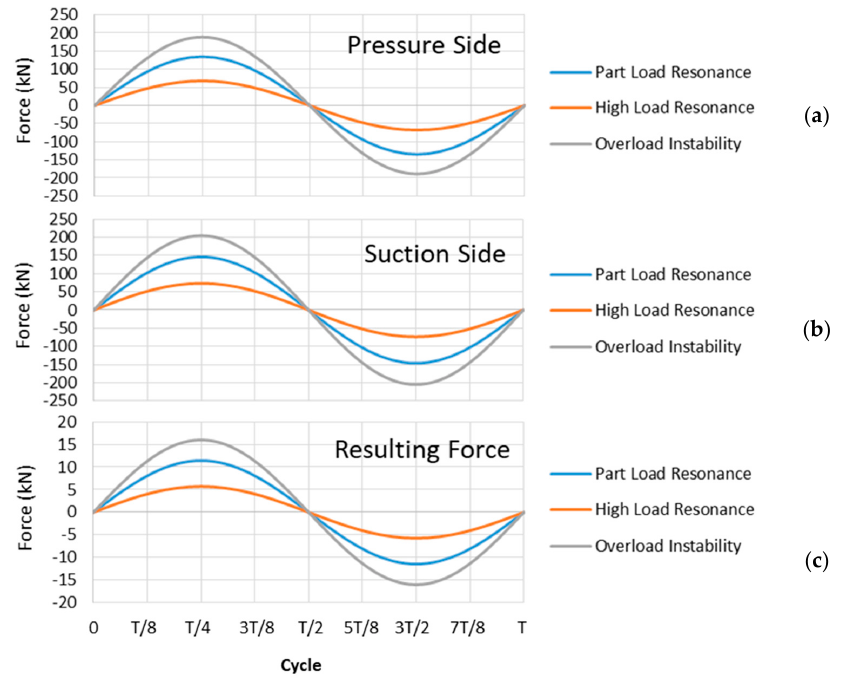
Figure 19. Force integrated over the pressure side ( a ) and over the suction side ( b ) of one blade. Resulting tangential force over one blade ( c ).